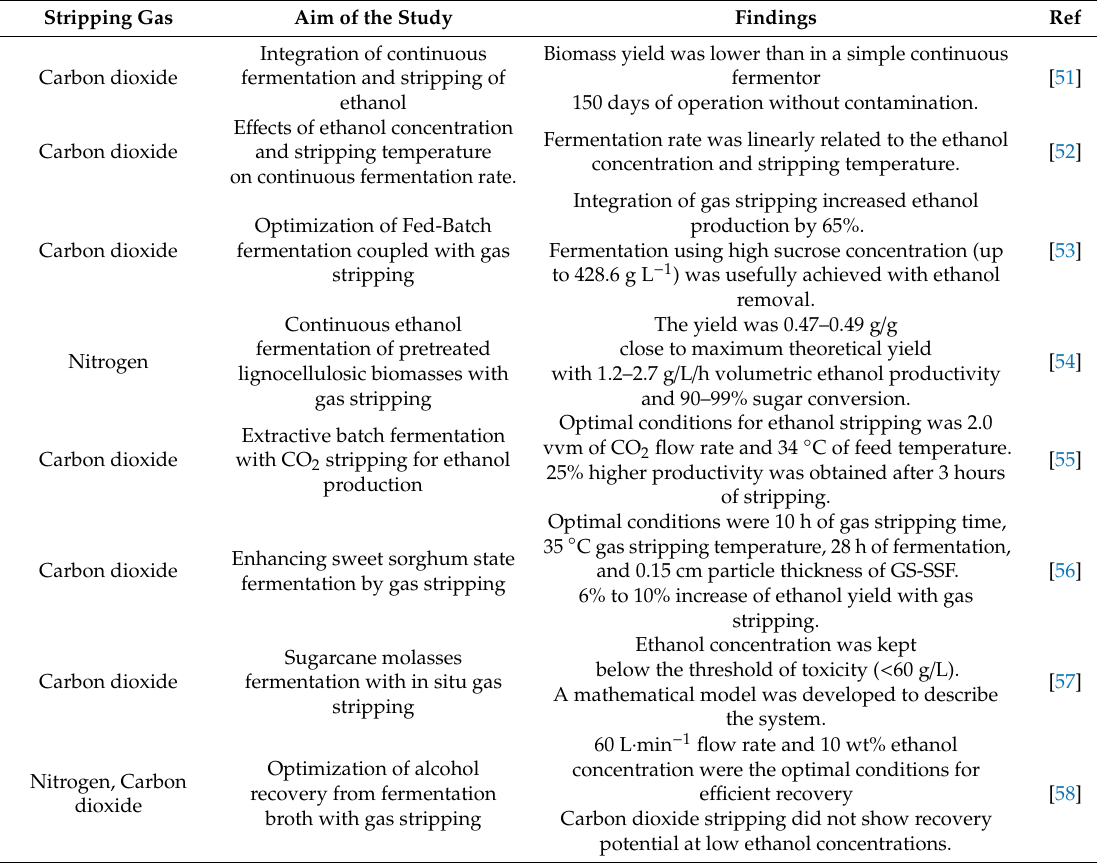
Table 2. Summary of studies about the fermentation-gas stripping coupled